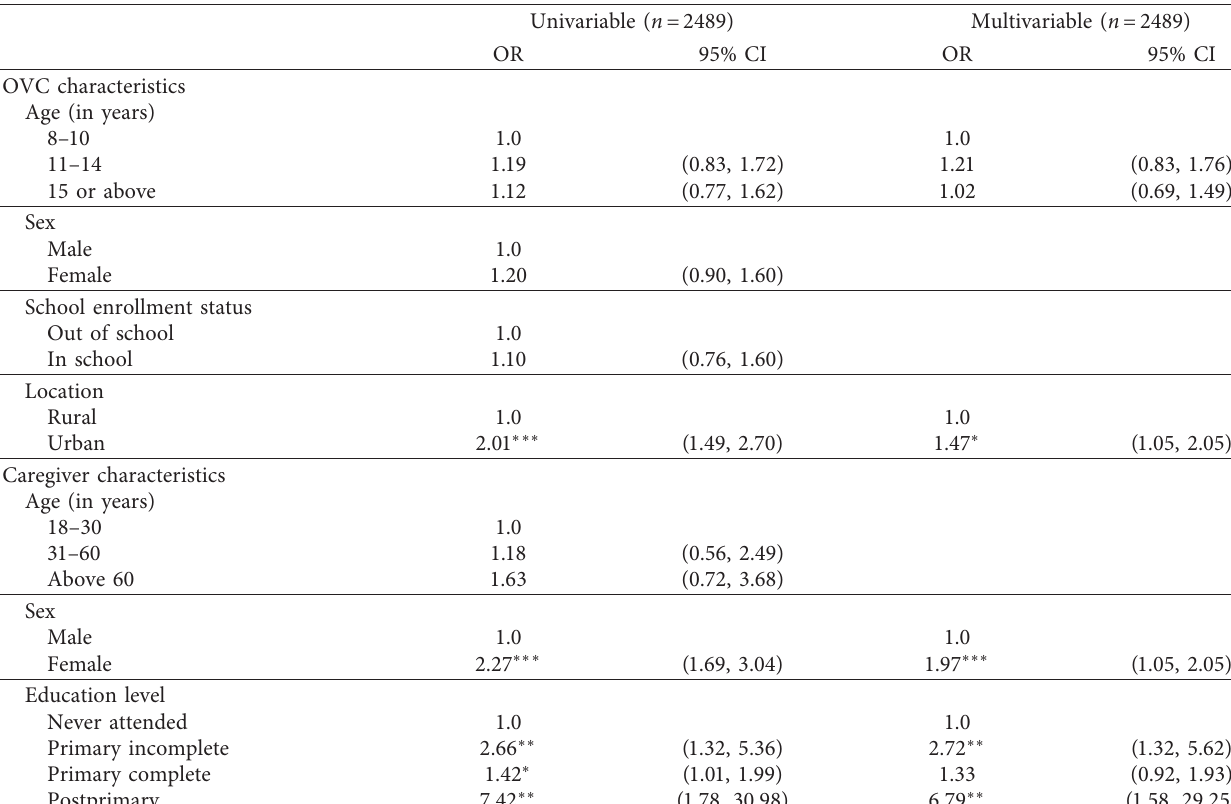
Table 5: Characteristics associated with disclosure status of OVC living with caregivers of multiple